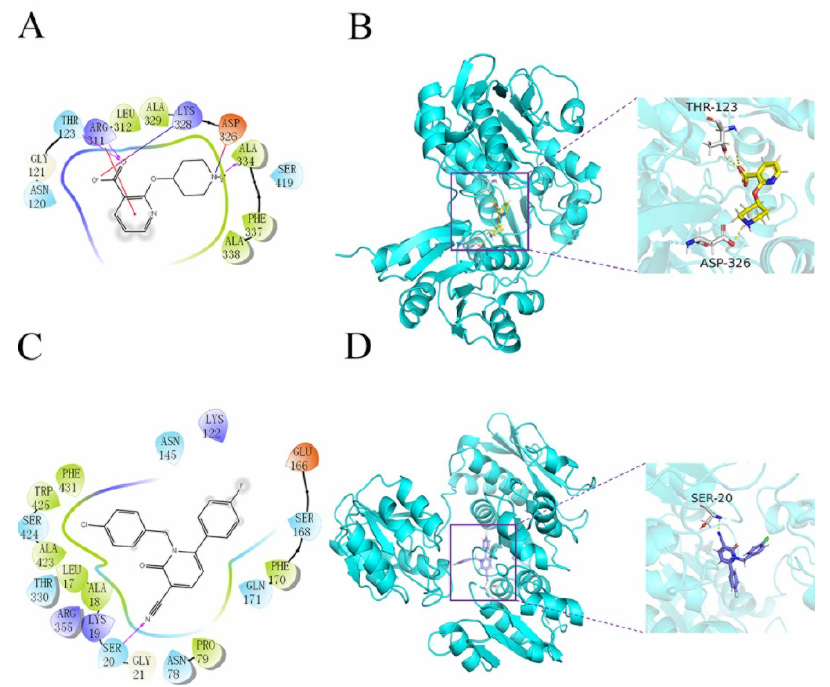
Figure 3. 2D and 3D images of 57568 and 3702 interacting with proteins. ( A ) 2D action diagram 57568. ( B ) 3D action diagram of 57568. ( C ) 2D action diagram of 3702. ( D ) 3D action diagram of 3702. The yellow and purple bars represent 57568 and 3702 compounds, respectively. The gray bars represent hydrogen bonding residues, and the yellow dotted lines represent hydrogen bonding.